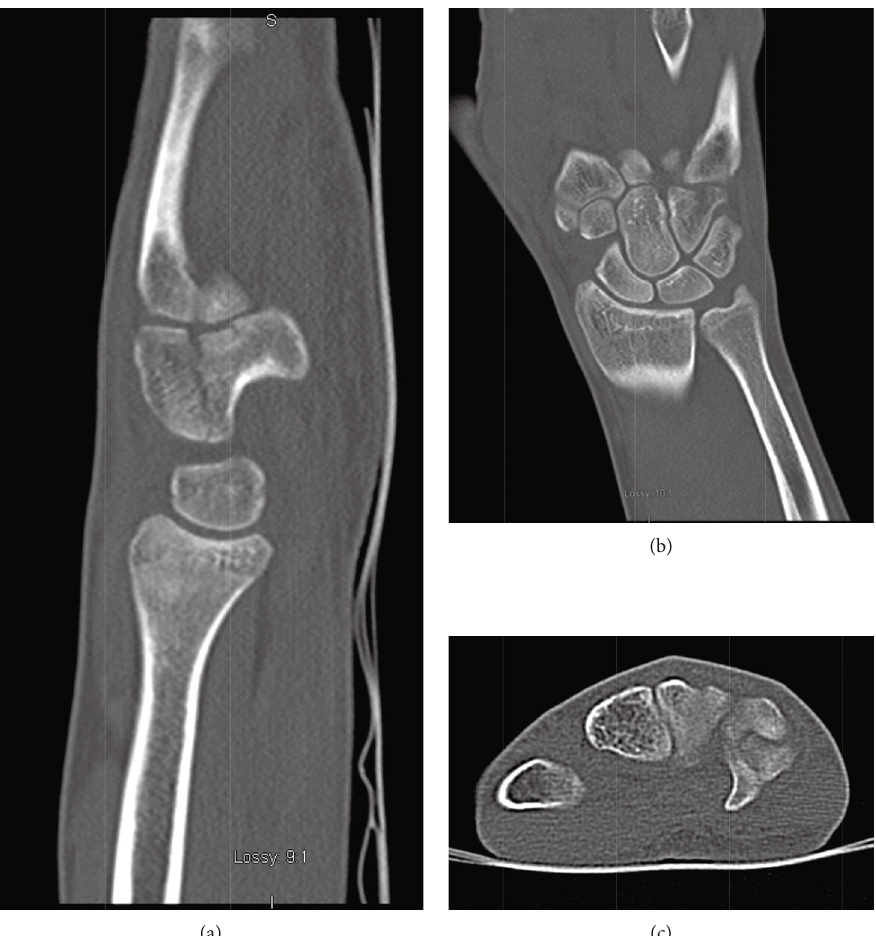
Figure 2: (a – c) CT images showing a longitudinal split fracture of both the hook and body of the hamate with 2mm of dorsal displacement and intra-articular extension involving the CMC joint.